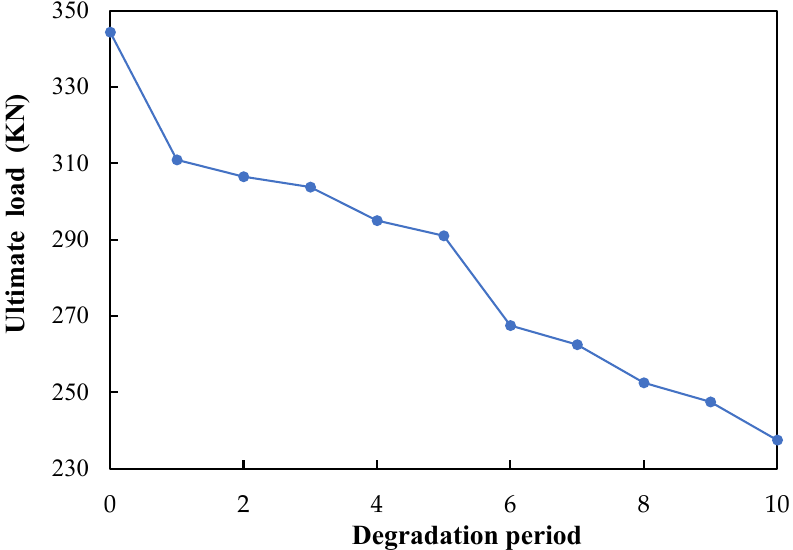
Figure 14. Ultimate loads of degraded reinforced concrete beams in the degradation periods 0–10.